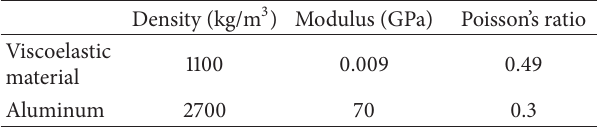
Table 1: Mechanical property of each material.